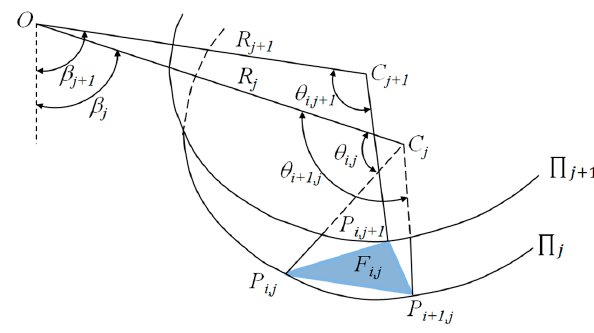
Figure 3. “Point-by-point” technique.